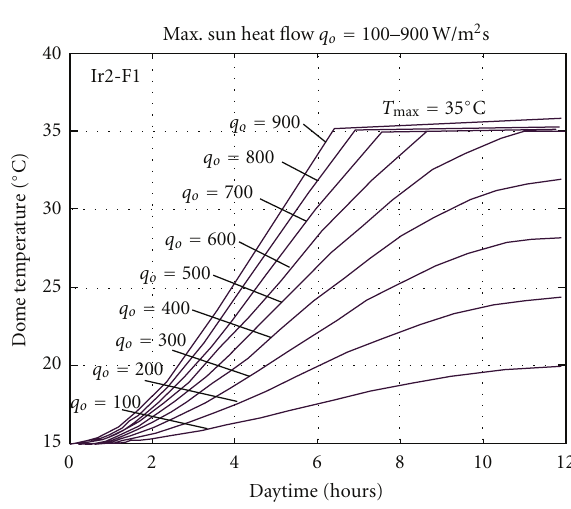
Figure 15: Heating of the dome by solar radiation from the night temperature of 15 ◦ C to 35 ◦ C via daily maximal solar radiation (W/m 2 ) for varying daily time. Height of dome film cover equals H = 135 m. The control temperature system limits the maximum internal dome temperature to 35 ◦